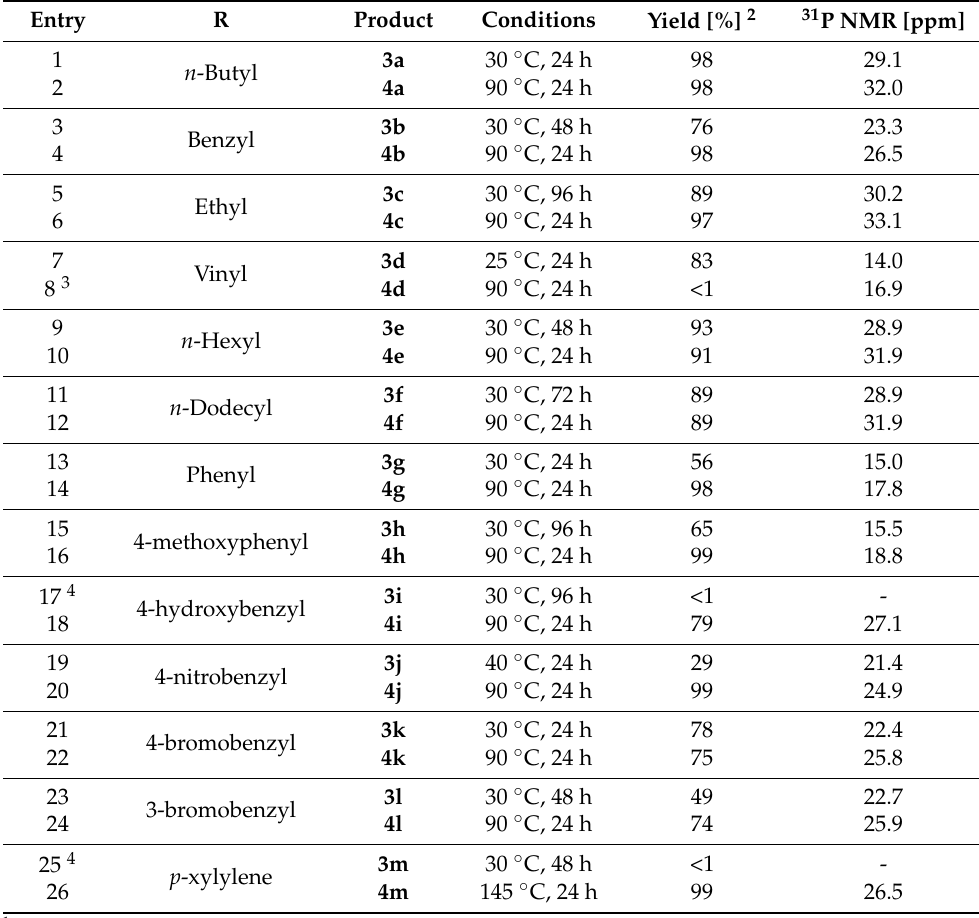
Table 4. The yields of mono- ( 3 ) and diesters ( 4 ) obtained from respective phosphonic acids ( 1 ) with triethyl orthoacetate 2a as ethoxy group donor and solvent; 1 Sections 3.5 and